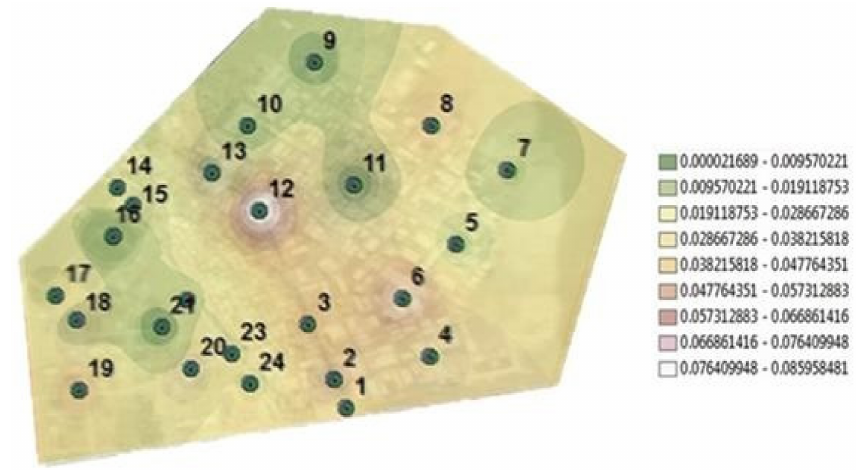
Figure 5. PM 10 concentration ( µ g/m 3 ) distribution throughout the day.